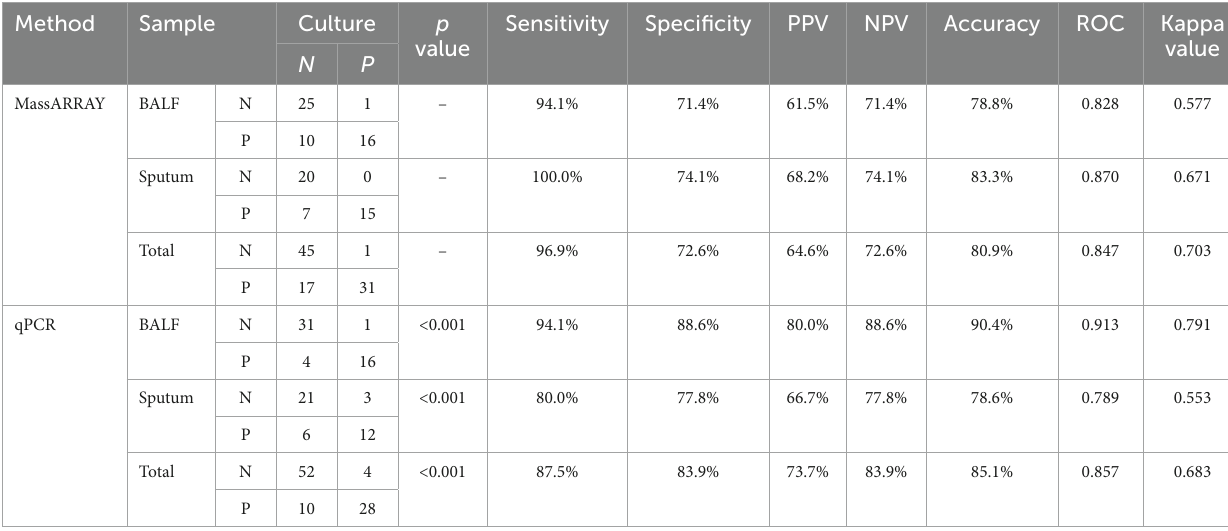
TABLE 3 Detection efficiency of tuberculosis identification in clinical